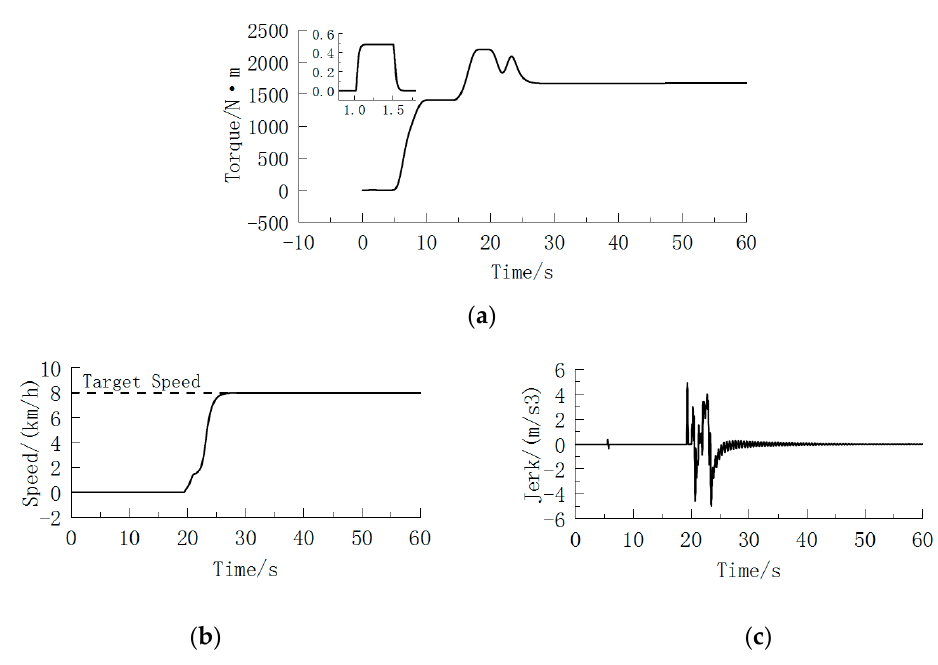
Figure 14. Control Process of 32% Inclination Condition: ( a ) Curve of Motor Output Torque; ( b ) Curve of Vehicle Velocity; ( c ) Curve of Jerk.